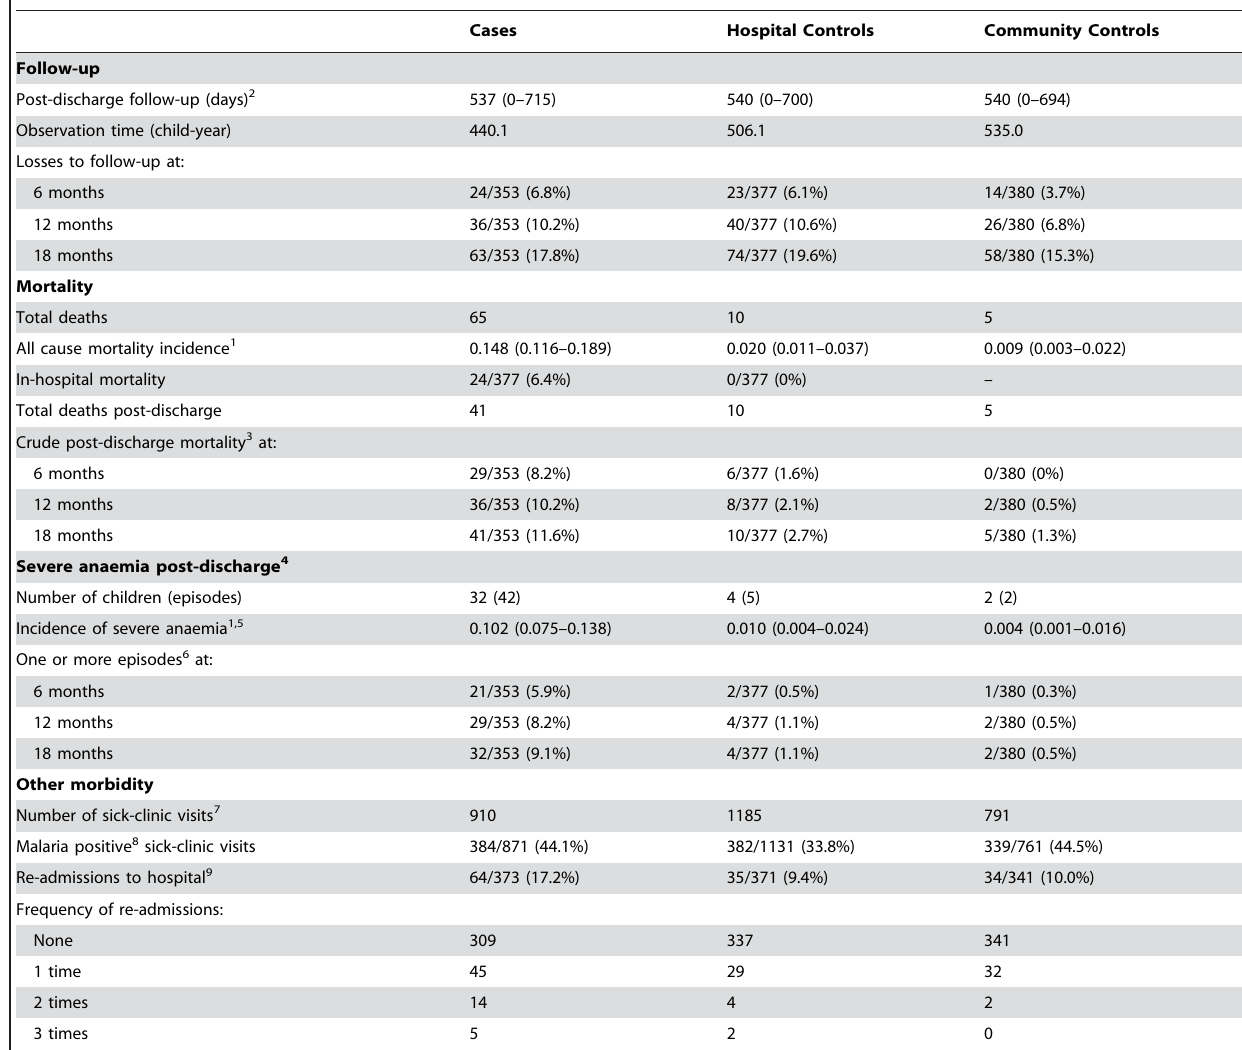
Table 2. All cause mortality and morbidity by study